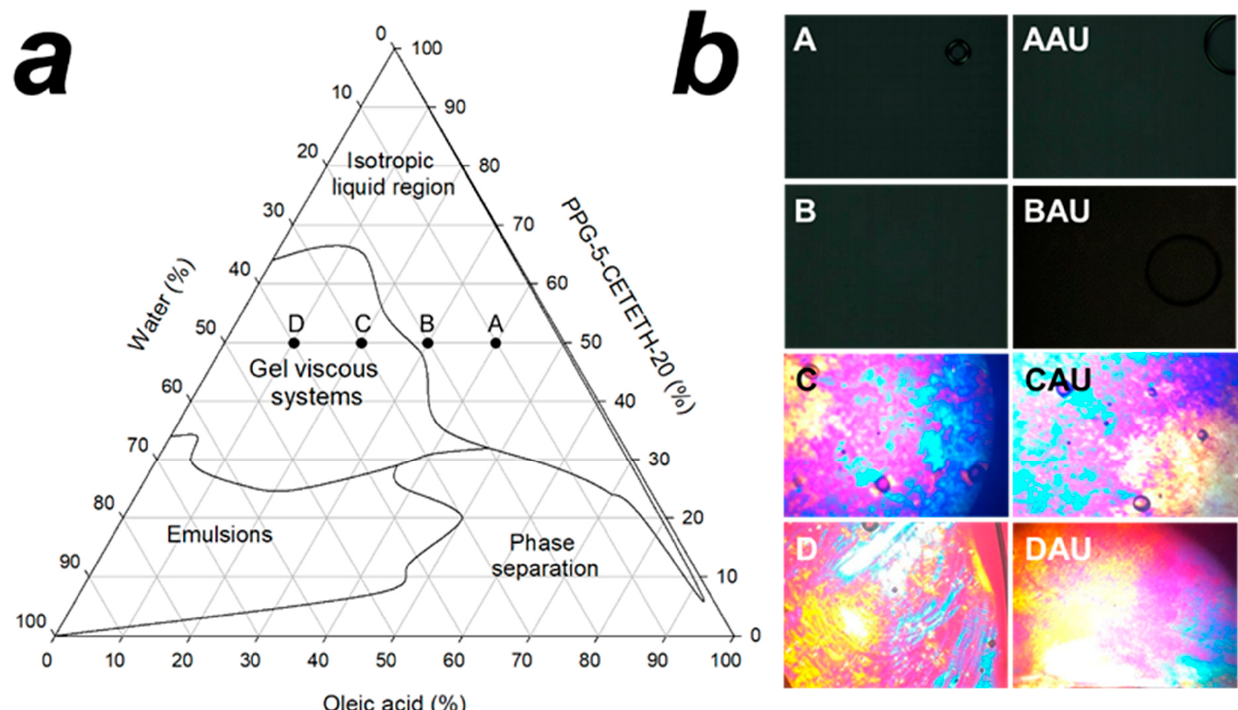
Figure 1. Phase ternary diagram of PPG-5-CETETH-20, oleic acid, and water mixture and their macroscopic visual characterization regions: inner symbols denoted the chosen formulations ( a ); polarized light microscopy obtained at 40 × of magnification ( b ). A = formulation with OA%/S%/W% ratio of 40/50/10; B = formulation with OA%/S%/W% ratio of 30/50/20; C = formulation with OA%/S%/W% ratio of 20/50/30; D = formulation with OA%/S%/W% ratio of 10/50/40; AAU = formulation A loaded with AU; BAU = formulation B loaded with AU; CAU = formulation C loaded with AU; DAU = formulation Dloaded with AU.